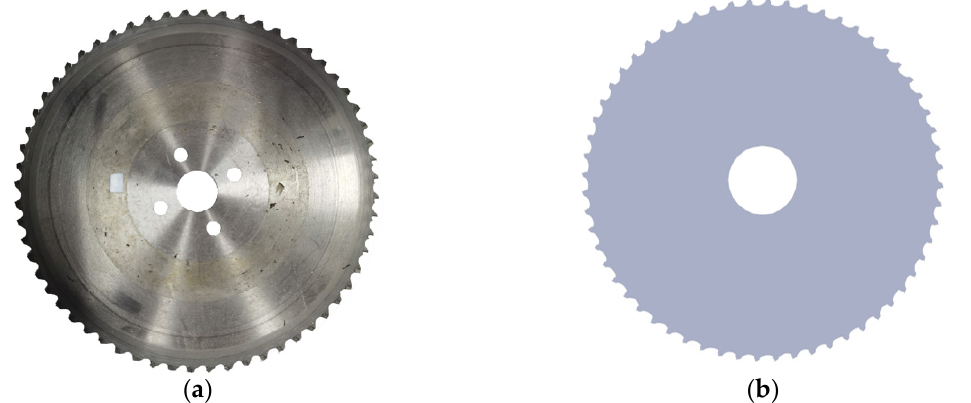
Figure 5. Modeling construction of carbide circular saw blade: ( a ) real one, ( b ) modeling one.